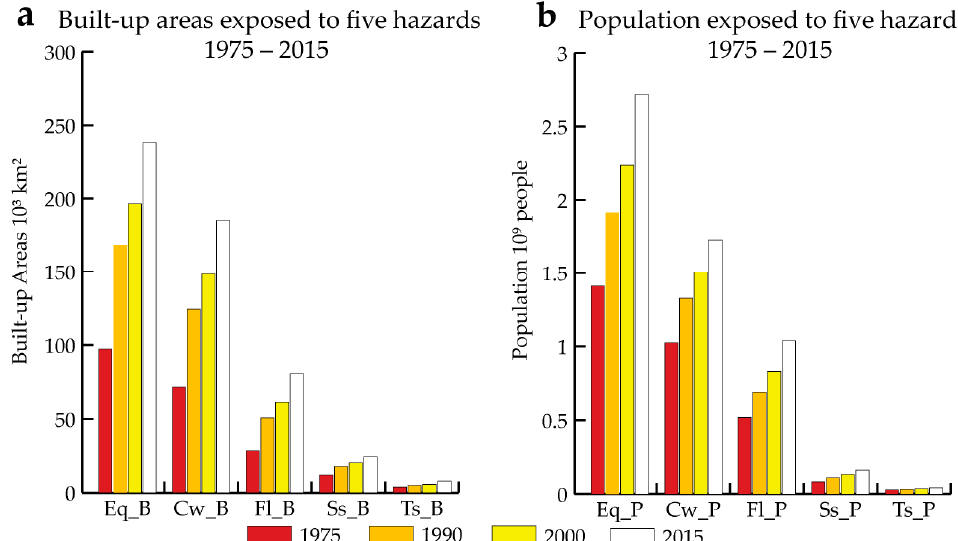
Figure 3. Built-up ( a ) and population ( b ) exposed to hazards: earthquakes (Eq), Tsunamis (Ts) with return period of 475 years; Cyclone winds (Cw) and Sea level surge (Ss) with return periods of 250 years; and Floods (Fl) with return periods of 100 years. Table 2. Global figures of built-up areas and population exposed to the different hazards per epoch. Hazards